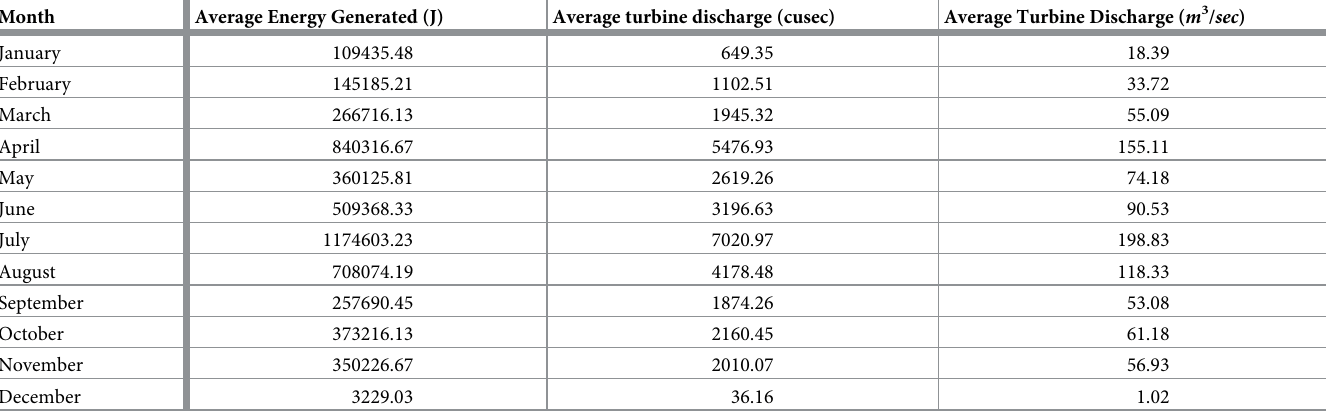
Table 2. Statistics of the average energy generation and turbine discharge